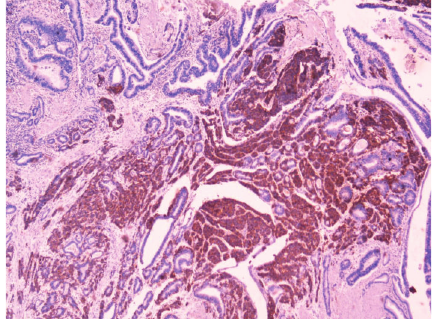
Figure 5: Cells stained with